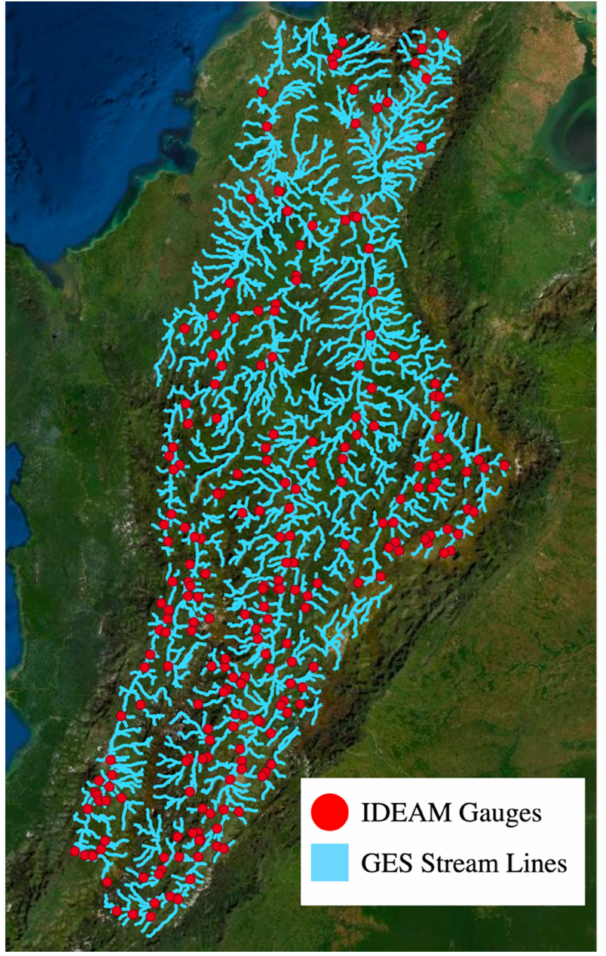
Figure 5. Magdalena River basin from the GES model’s stream network with IDEAM gauge locations